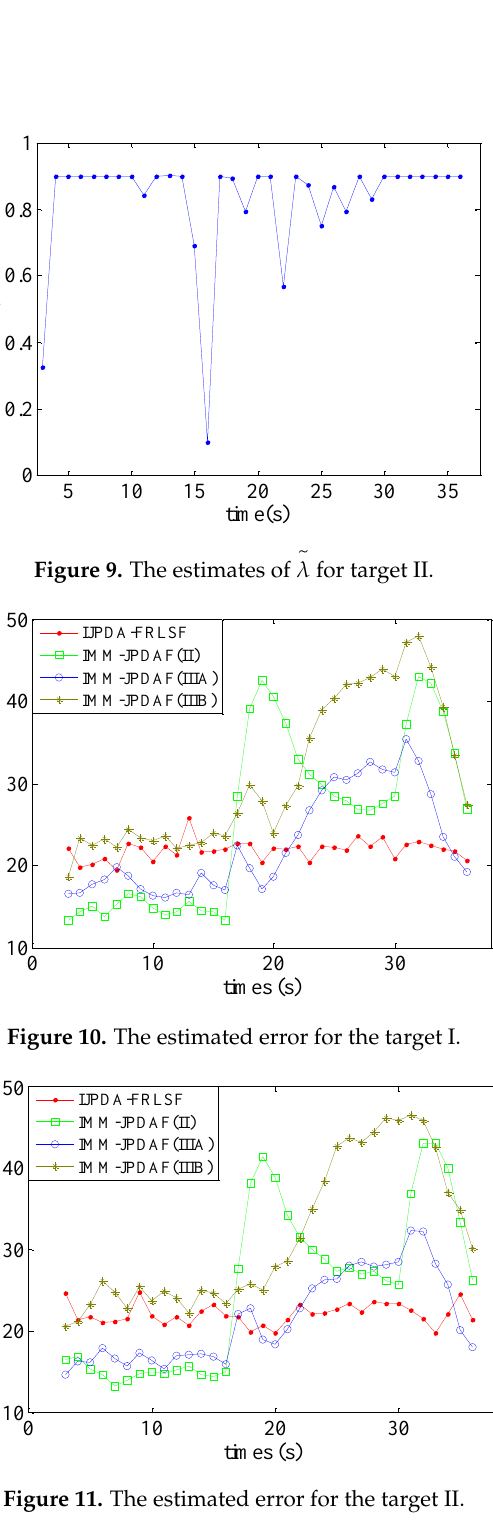
Figure 12. The real measurements for two targets.